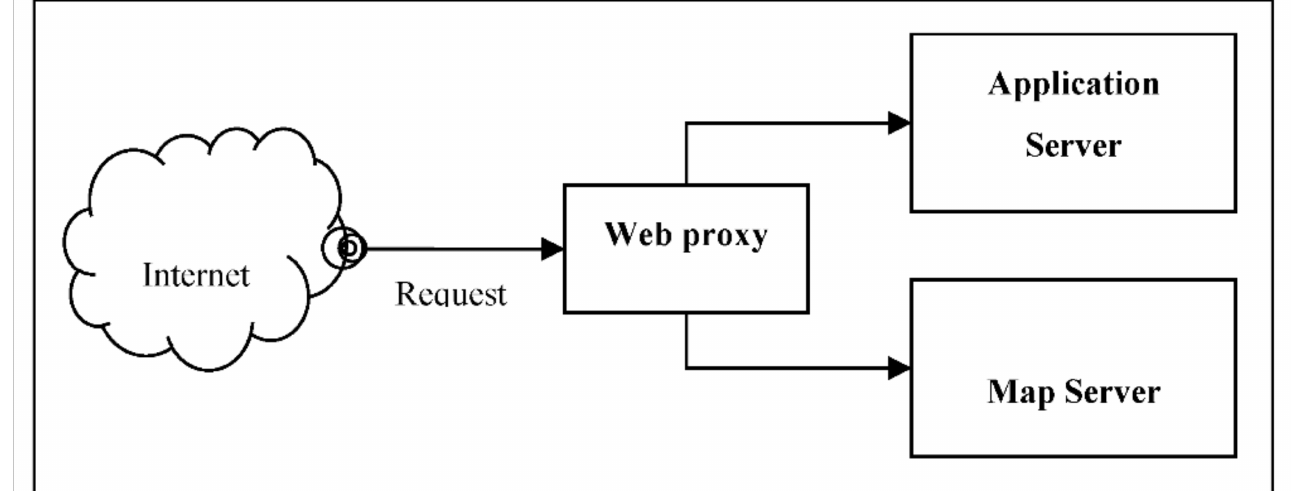
Figure 9. ArchTerr’s application block diagram architecture